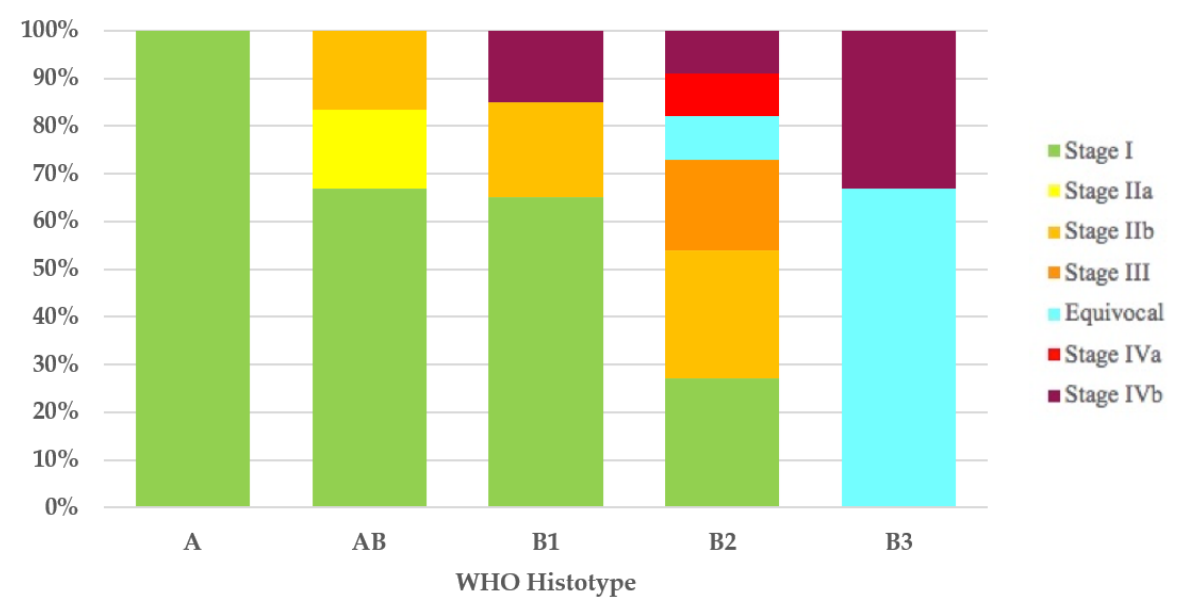
Figure 1. Stage distribution in thymoma histotypes according to the Masaoka–Koga staging system. WHO, World Health Organization.